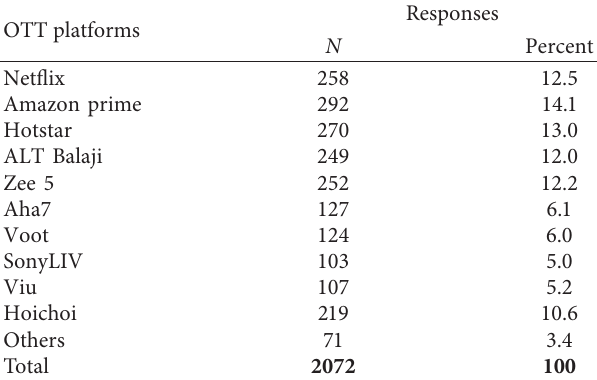
Table 3: OTT platform use